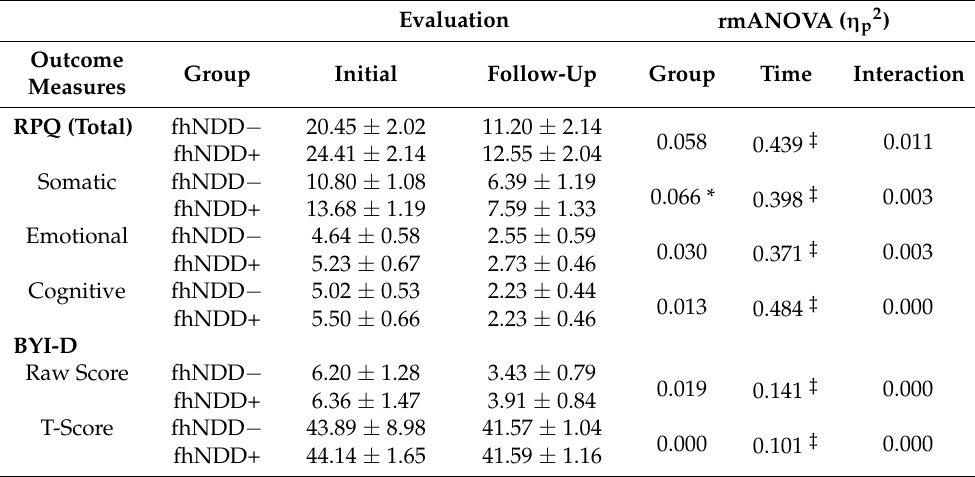
Table 2. Descriptive statistics for RPQ and Beck Youth Inventories—depression scale (BYI-D) scores at each